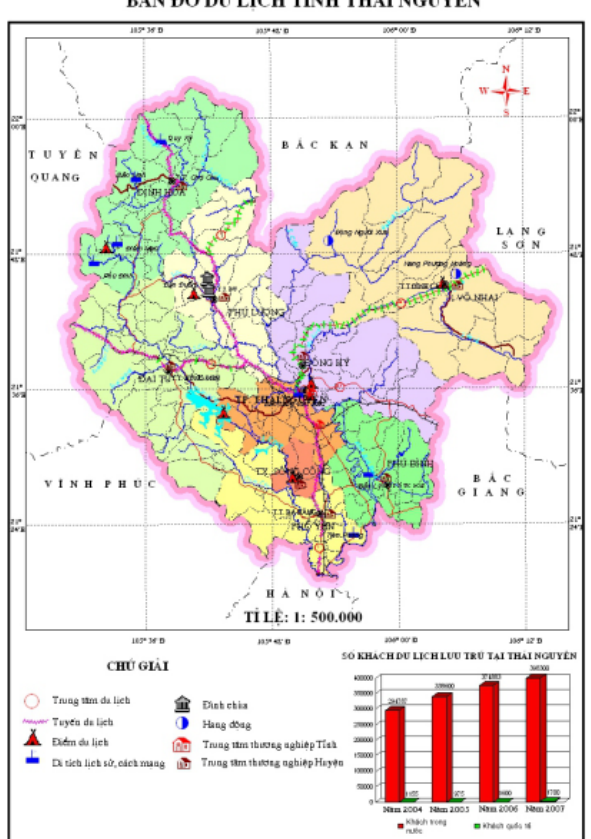
Figure 2: Tourist E.Atlas of Thai Nguyen